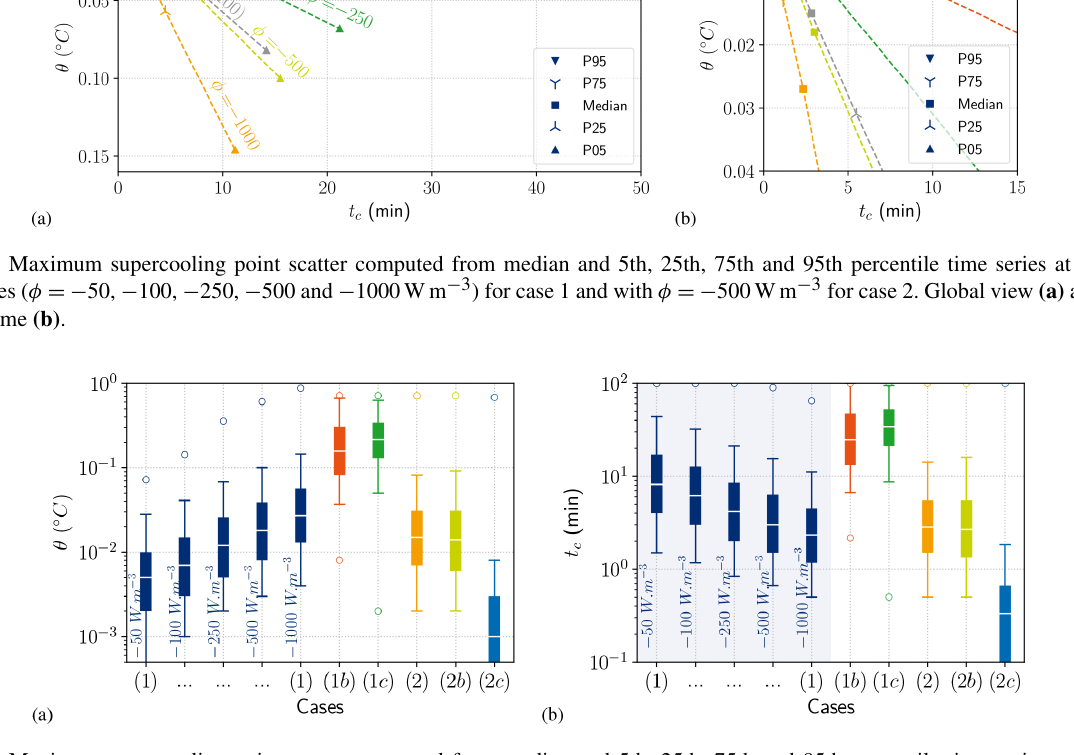
Figure 11. Maximum supercooling point scatter computed from median and 5th, 25th, 75th and 95th percentile time series at different cooling rates ( − 50, − 100, − 250, − 500 and − 1000Wm − 3 ) for case 1; comparison between the choice of the length scale δ T (cases 1b and 1c); and comparison between different initial conditions (cases 2b and 2c) with φ = − 500Wm − 3 . Maximum degree of supercooling (a) and maximum supercooling time (b) . The white line is the median, the wide box is delimited by the 25th and 75th percentiles, the thin line is delimited by the 5th and 95th percentiles, and the round dots corresponds to minimum and maximum